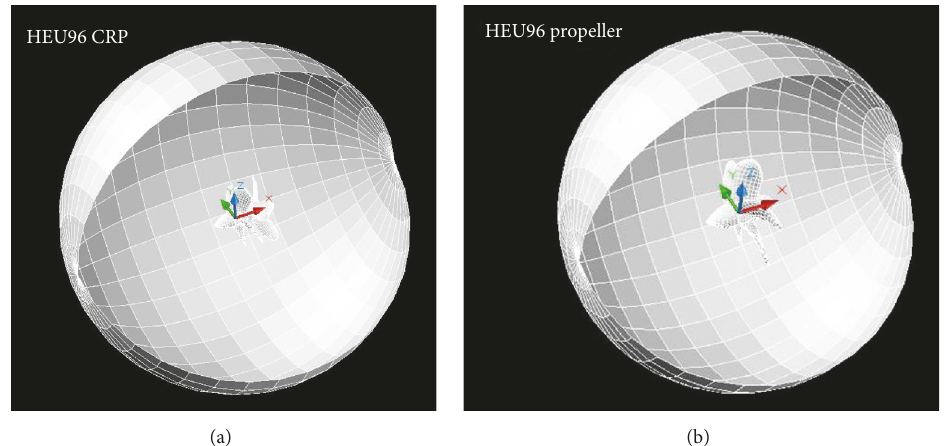
Figure 12: Spherical surfaces for calculation: (a) CRP spherical surface system and (b) single propeller spherical surface system.